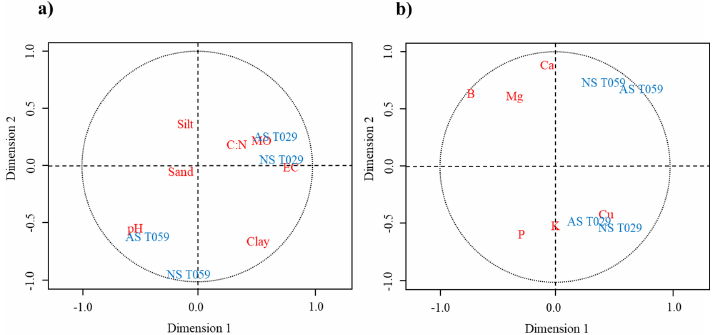
Figure 3. Canonical correlation analysis (CCA) based on soil parameters. ( a ) Diagram of soil parameters: sand, silt, clay, pH, electric conductivity (EC), soil organic matter (OM), C:N ratio (C:N). ( b ) Diagram of soil elements: assimilable phosphorus (P), cation potassium (K), calcium (Ca), magnesium (Mg), copper (Cu) and boron (B). Both diagrams Trichoderma development: natural soil T. harzianum (NS T059), natural soil T. velutinum (NS T029), autoclaved soil T. harzianum (AS T059) and autoclaved soil T. velutinum (AS